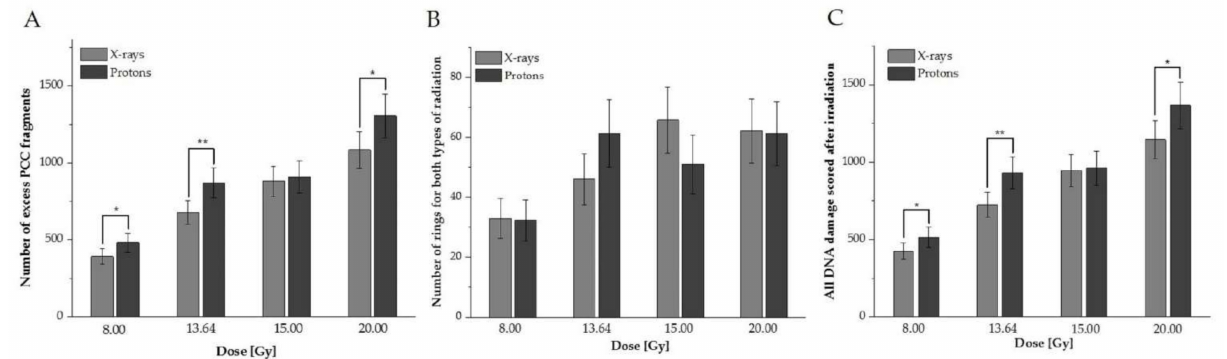
Figure 1. Average values for human peripheral blood lymphocytes (HPBLs) irradiated with doses of 8.00, 13.64, 15.00, or 20.00 Gy with protons vs. X-rays ( A : excess fragments, B : rings, C : all damage). The error bars represent the standard deviation. *, p < 0.05; **, p <